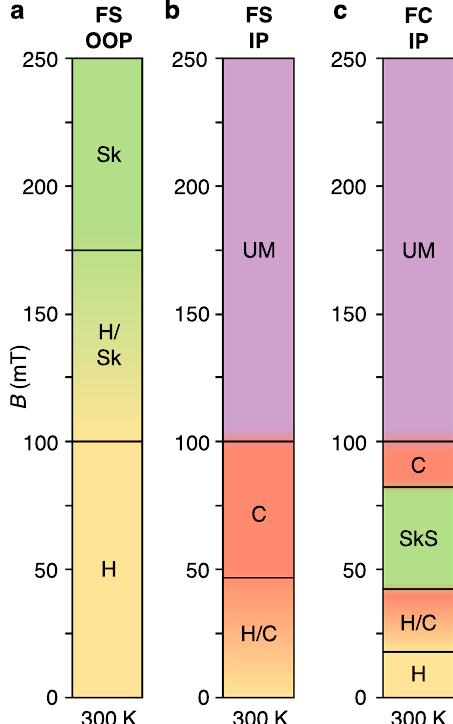
Fig. 2 Room temperature magnetic phase diagrams. a – c Diagrams indicating the magnetic state exhibited by the sample as a function of the applied magnetic fi eld when following different measurement protocols: performing a fi eld sweep (FS, − 250 to 250 mT) with an out-of-plane (OOP) magnetic fi eld ( a ), performing a FS with an in-plane (IP) magnetic fi eld ( b ), and fi nally when fi eld cooling (FC) at a range of IP magnetic fi elds ( c ). Labels indicate the formation of the helical (H, yellow), conical (C, red), isolated skyrmion (Sk, green), skyrmion string (SkS, green) and uniformly magnetised (UM, purple) spin